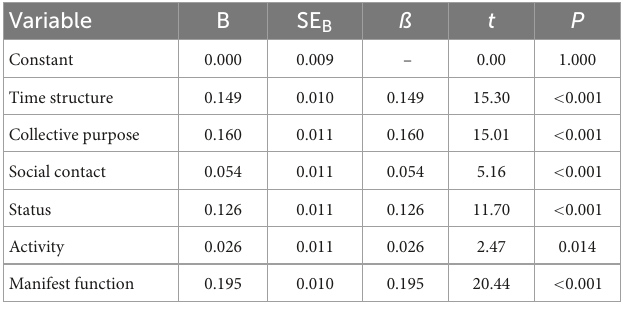
TABLE 5 Multiple regression analysis for the prediction of mental